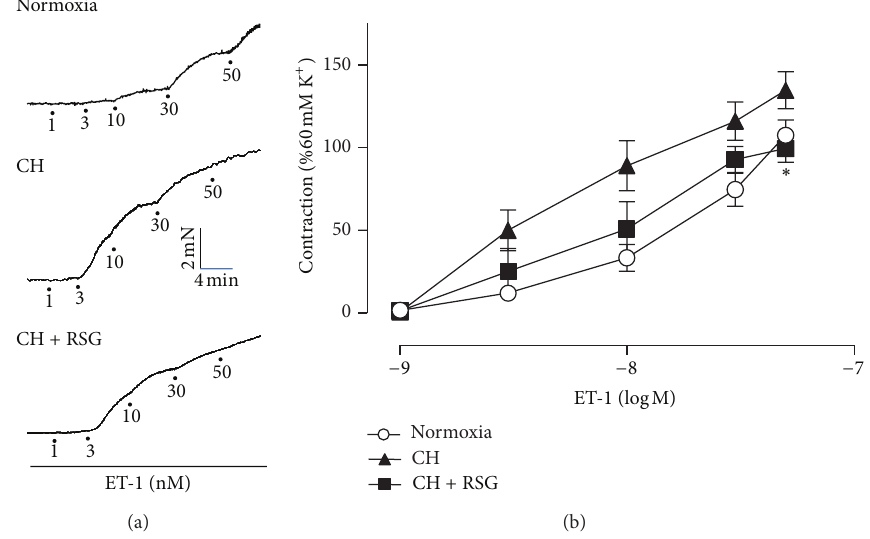
Figure 1: (a) Representative recordings of ET-1-induced contractions of pulmonary arteries from normoxia-, chronically hypoxic- (CH-), or rosiglitazone- (RSG-) treated CH-rats. (b) RSG ameliorated ET-1-mediated vasoconstriction in pulmonary arteries from the rats with PAH. Data were mean ± SEM from 5 to 7 rats. ∗ 𝑃 < 0.05 CH + RSG versus CH